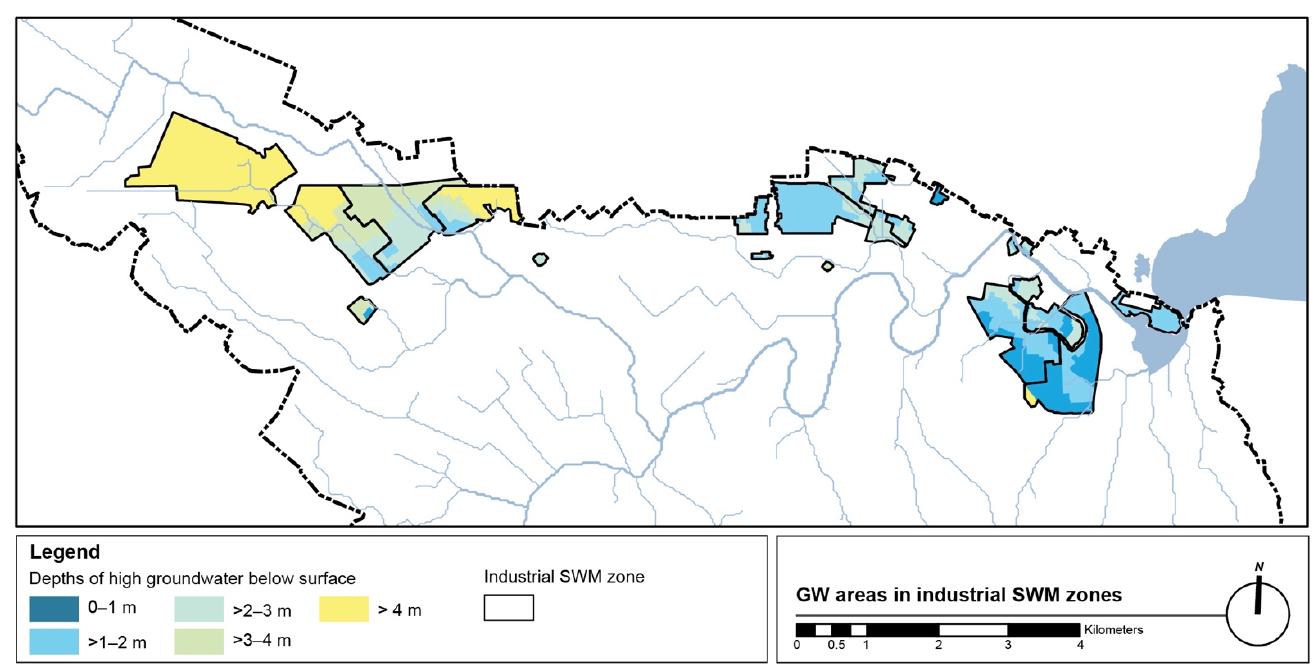
Figure 5. GW areas within SWM zones located in the Heathcote River catchment were delineated based on the maximum high groundwater from historical records.